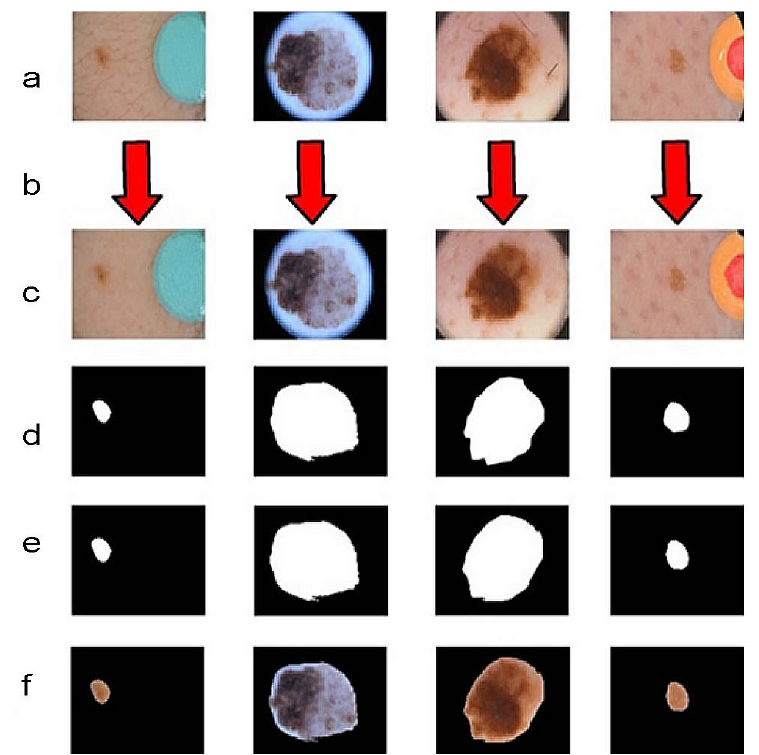
Figure 11. Results in the segmentation phase with images with black frame and band-aid